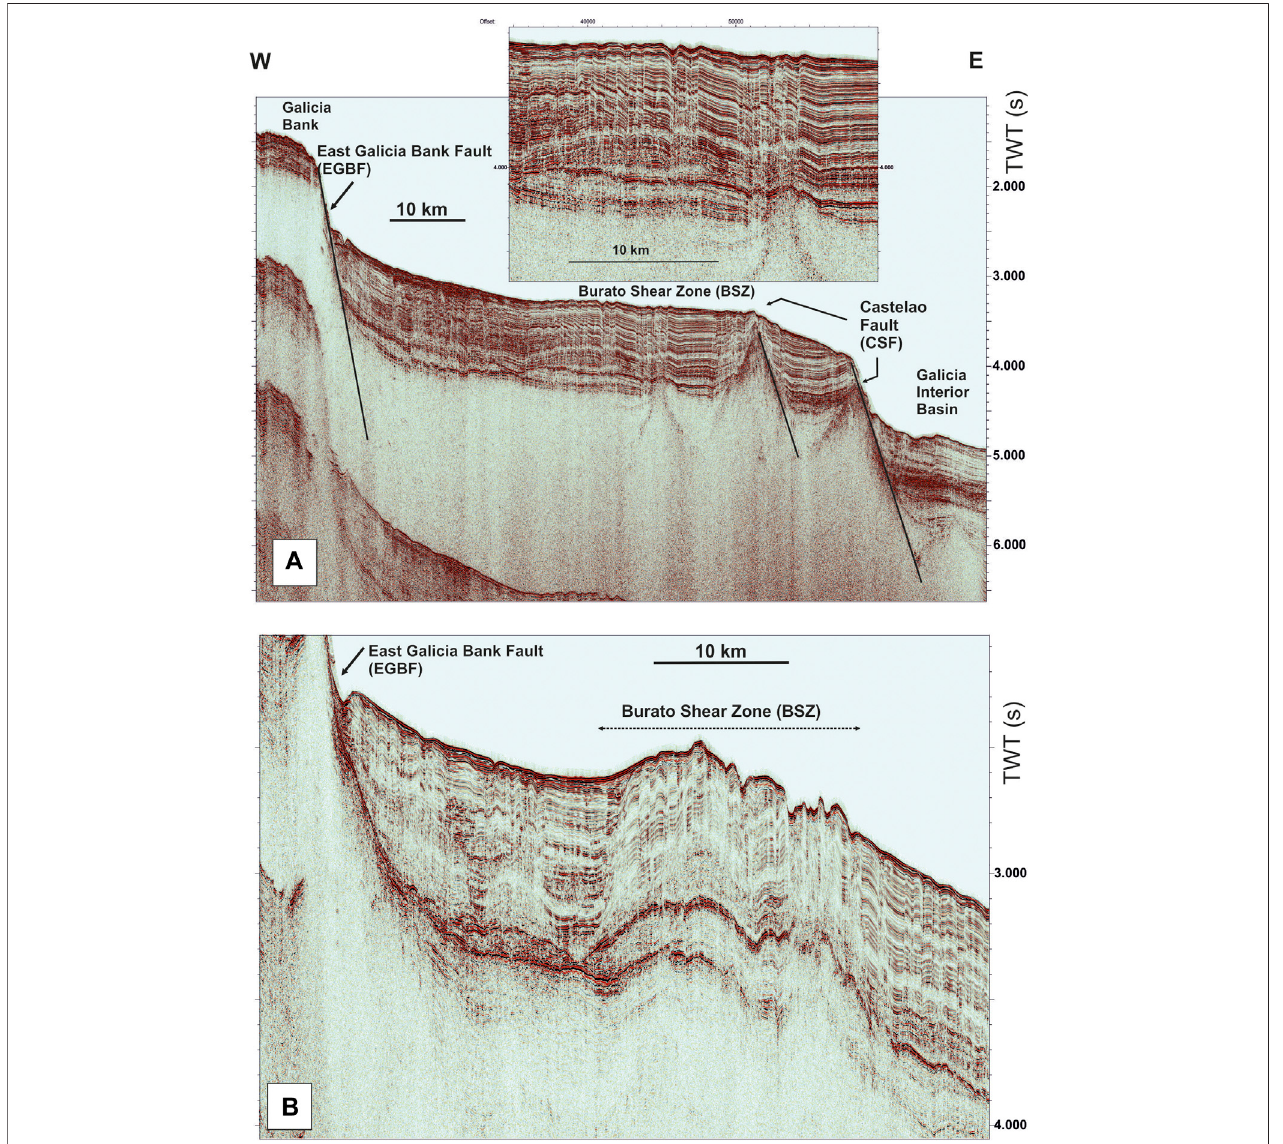
FIGURE 13 | High-resolution multichannel seismic pro fi les crossing the Burato Shear Zone (BSZ) bounded by the Castelao Fault (CSF in Figure 12 ). The Burato Shear Zone shows a prominent elongated WNW-ESE trending dome bounded by a dense network of sub-vertical faults. Location of pro fi les is shown in Figure 12 .